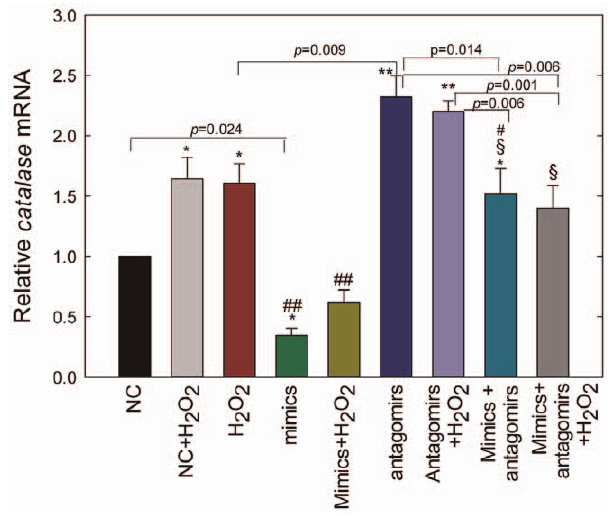
Figure 7. Antagomirs of miR-30b protect ARPE-19 cells from miR-30b mimics-mediated inhibition of catalase expression under oxidative condition. Cells were transfected with NC (20 nM), mimics (20 nM), antagomirs (50 nM), or mimics + antagomirs, and incubated for 24 h before harvesting for total RNA extraction; H 2 O 2 (200 uM) was added for the last 18 h. Catalase mRNA levels were expressed relative to Hprt mRNA with the value of the scrambled miRNA-transfected control (NC) set to 1. Values are presented as mean 6 SEM; n=4. * p , 0.05 vs. control (NC), ** p , 0.001 vs. NC/mimics/ mimics + H 2 O 2 /mimics + antagomirs + H 2 O 2 , 1 p , 0.001 vs. mimics/mimic-